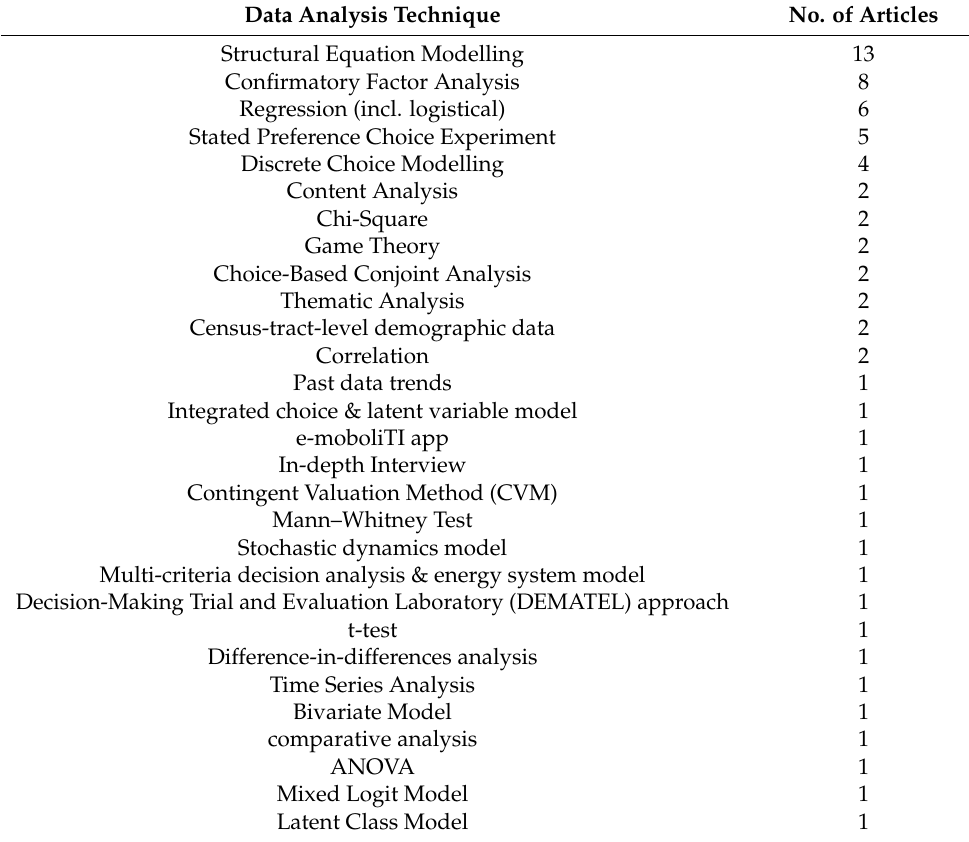
Table 5. Data analysis techniques adopted in the reviewed